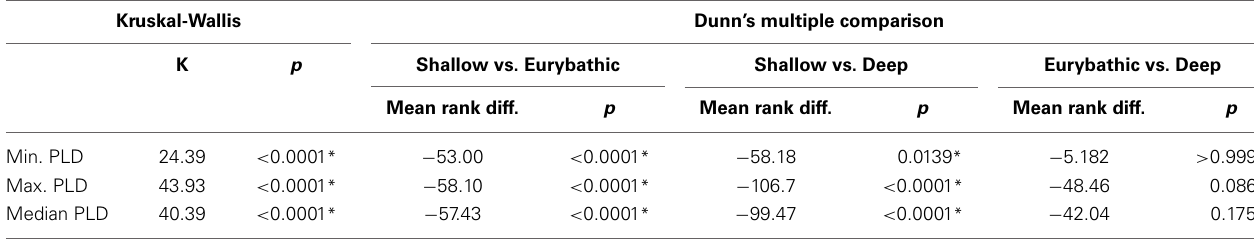
Table 3 | Results of the Kruskal-Wallis and Dunn’s multiple comparison tests used to investigate differences of minimum, maximum and median values between shallow, eurybathic and deep species.